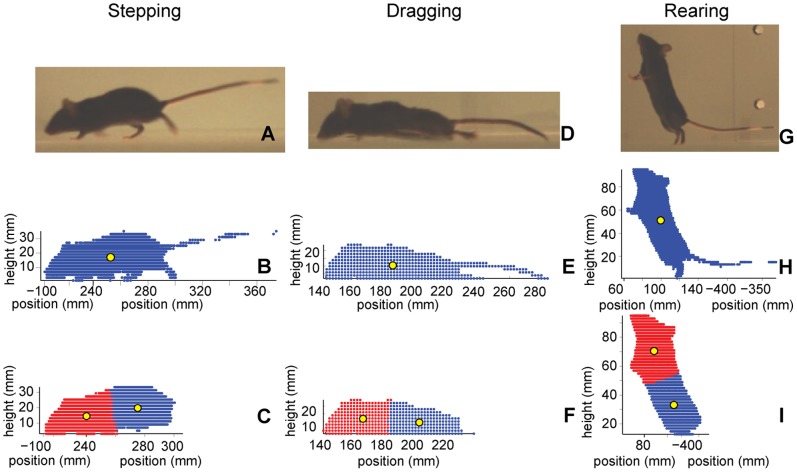
Video frames and corresponding reconstructed 3D volumes of whole and segmented mice.Representative video frames of directed locomotion (A), dragging (D) and rearing (G). The corresponding reconstructed 3D volumes of subjects including the tail (B, E, H), and divided into front and rear segments without the tail (C, F, I). The center of volume of the animal’s front and rear halves are used in the detailed analysis of directed locomotion bouts to reduce the influence of head motion.